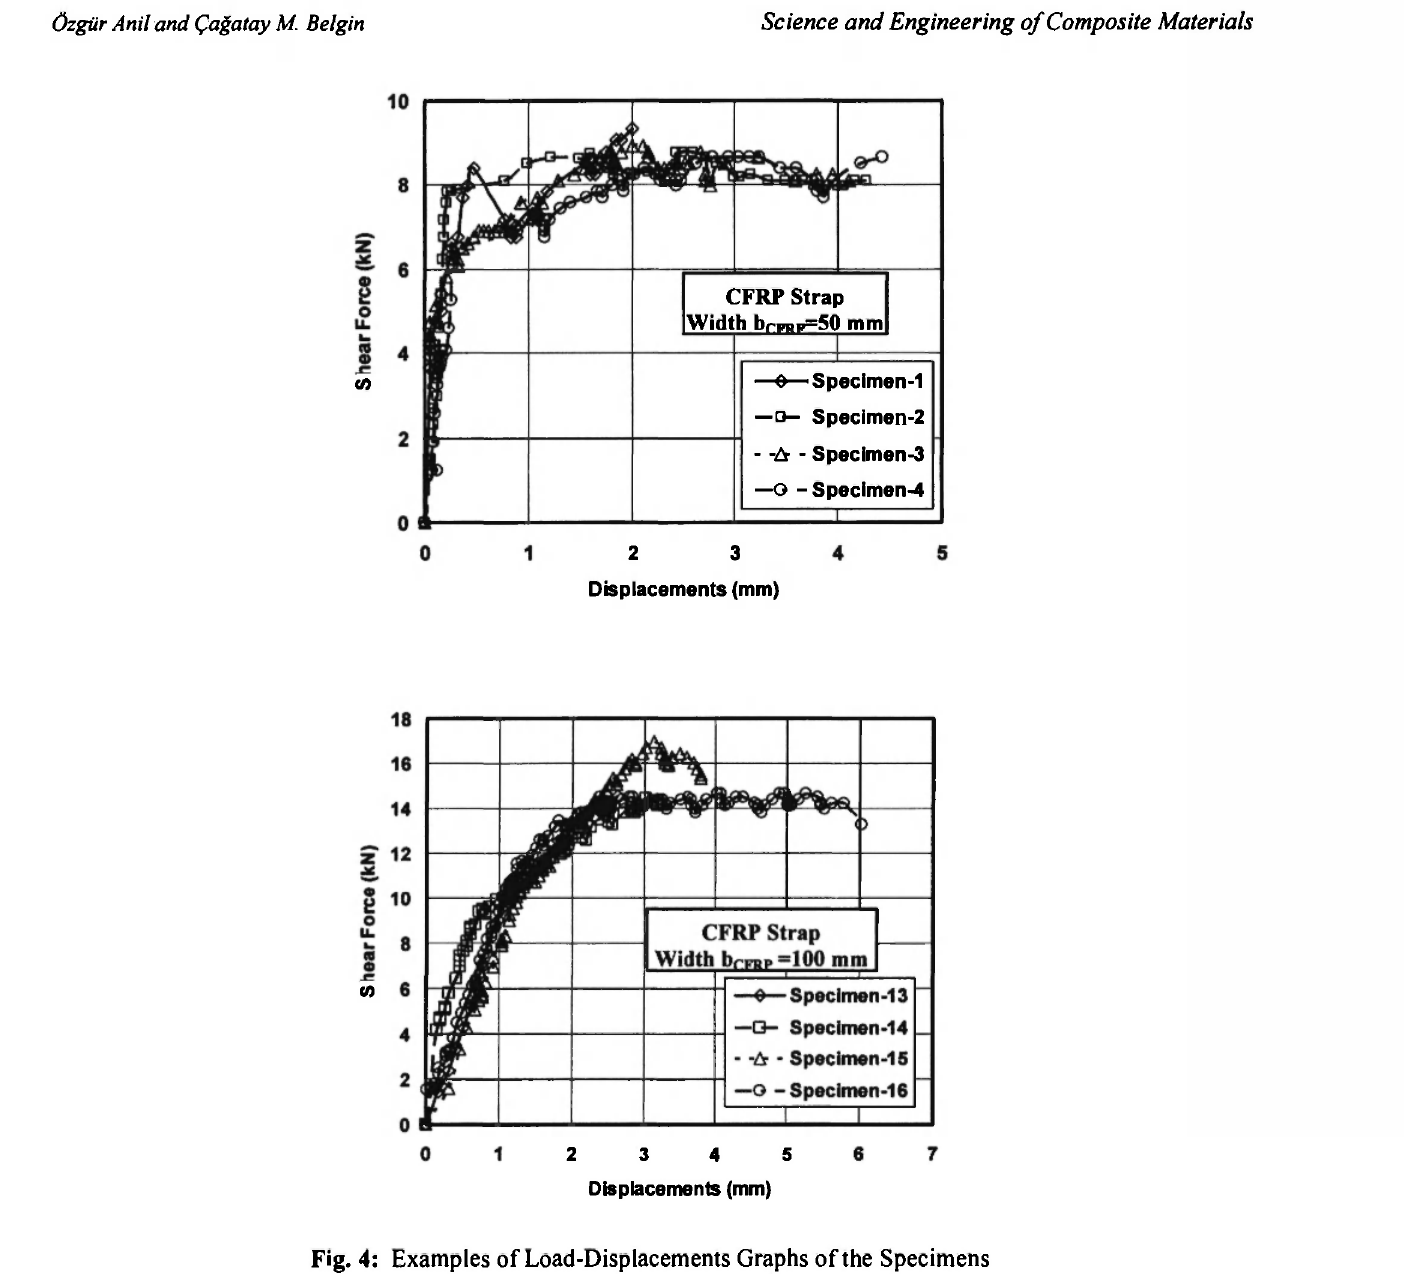
Fig. 4: Examples of Load-Displacements Graphs of the